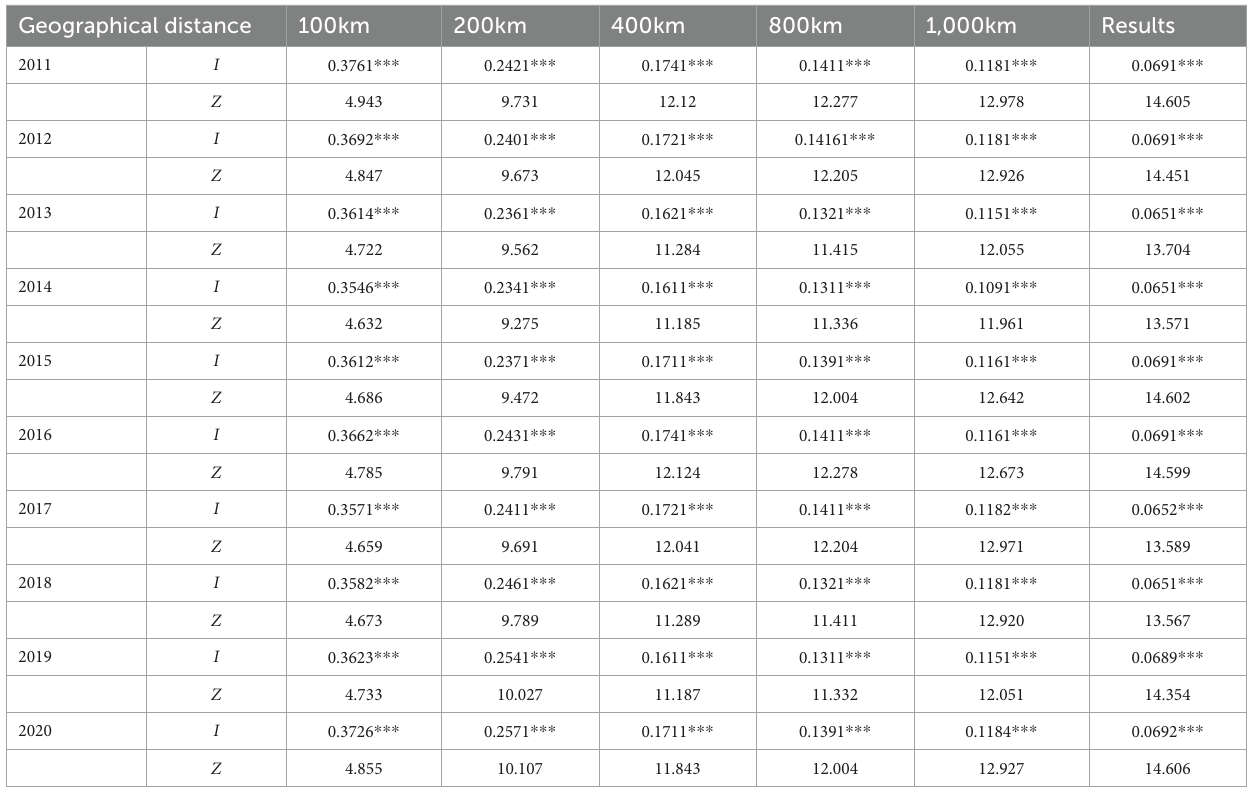
TABLE 8 Moran’s I index of urban greening development level under different spatial distance thresholds. Geographical